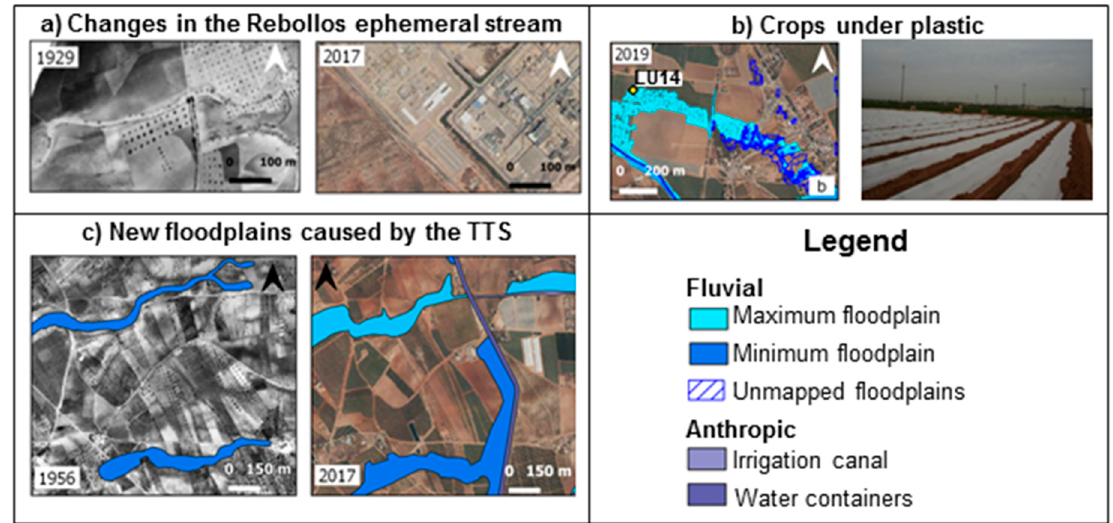
Figure 15. Human interventions that alter flooding in the Rebollos watershed. ( a ) the Rebollos ephemeral stream disappears due to the terrain modification to an industrial estate, ( b ) flow rate and exposure increase as a result of the use of plastic on crops, and ( c ) loss of floodplain connectivity, and consequently, increased exposure of new areas to flooding.